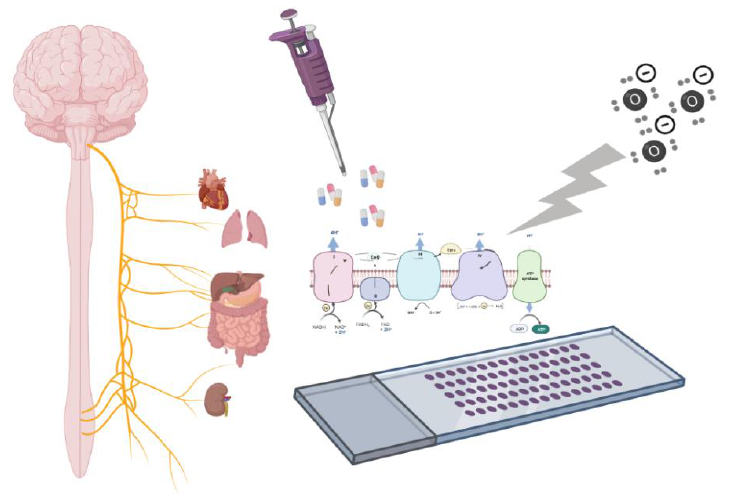
Figure 1. Scheme of the methodology used to evaluate the tissue-specific drug-mediated superoxide formation in human tissues. CMMAs were composed of human cell membranes from 10 different organs and tissues. Drugs and compounds with antipsychotic, antidepressant, anticholinergic, narcotic, and analgesic properties were incubated with CMMAs, and superoxide formation was detected by a colorimetric assay. CMMAs were digitalized, and the data after normalization were analyzed to determine ROS formation in each human tissue.